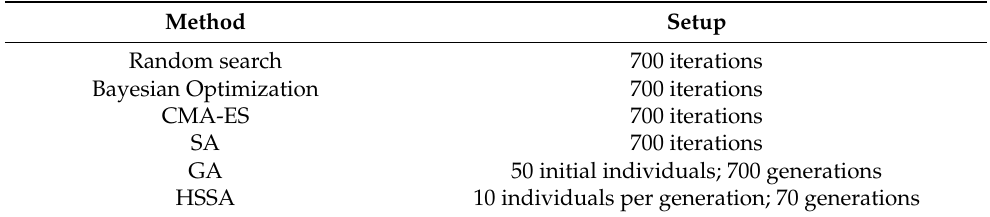
Table 4. Settings of each algorithm in the performance verification experiment on MNIST.